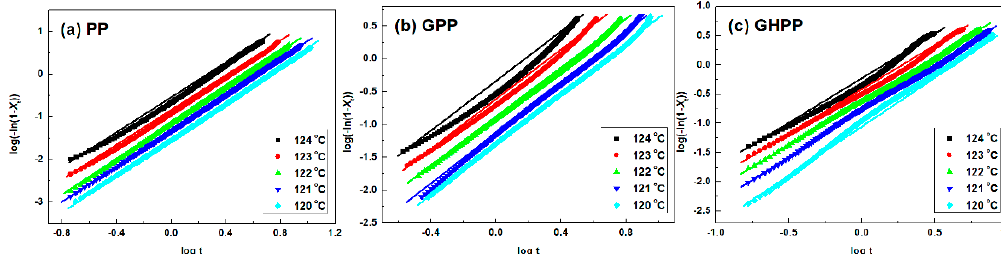
Figure 5. Avrami plots of log [ − ln(1 − X t ) ] versus logt for isothermal crystallization process for ( a ) neat PP ( b ) GPP, and ( c ) GHPP.